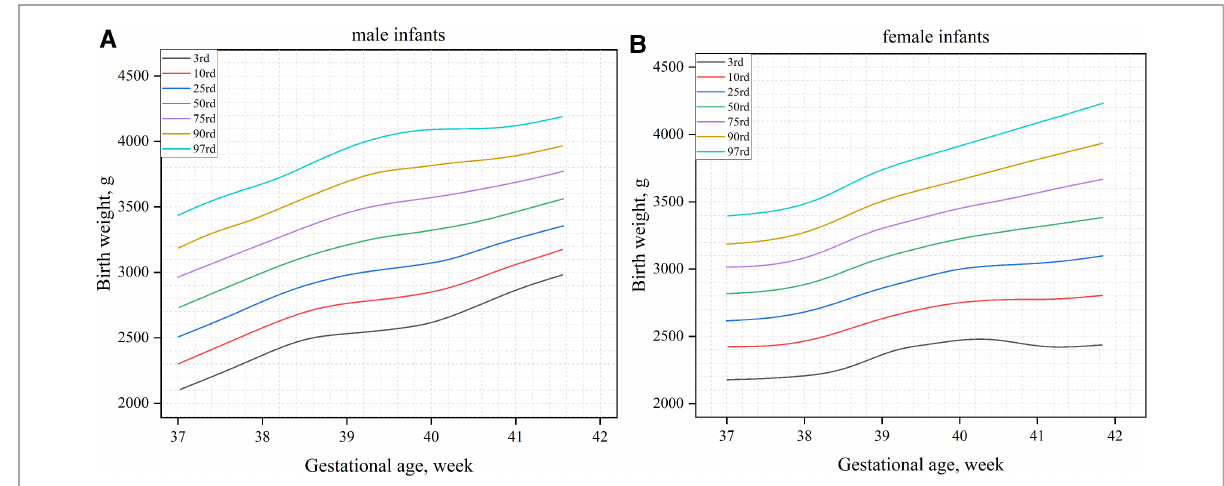
FIGURE 1 Birth weight percentile curves by gender and gestational age ( A ): male infants; ( B ): female